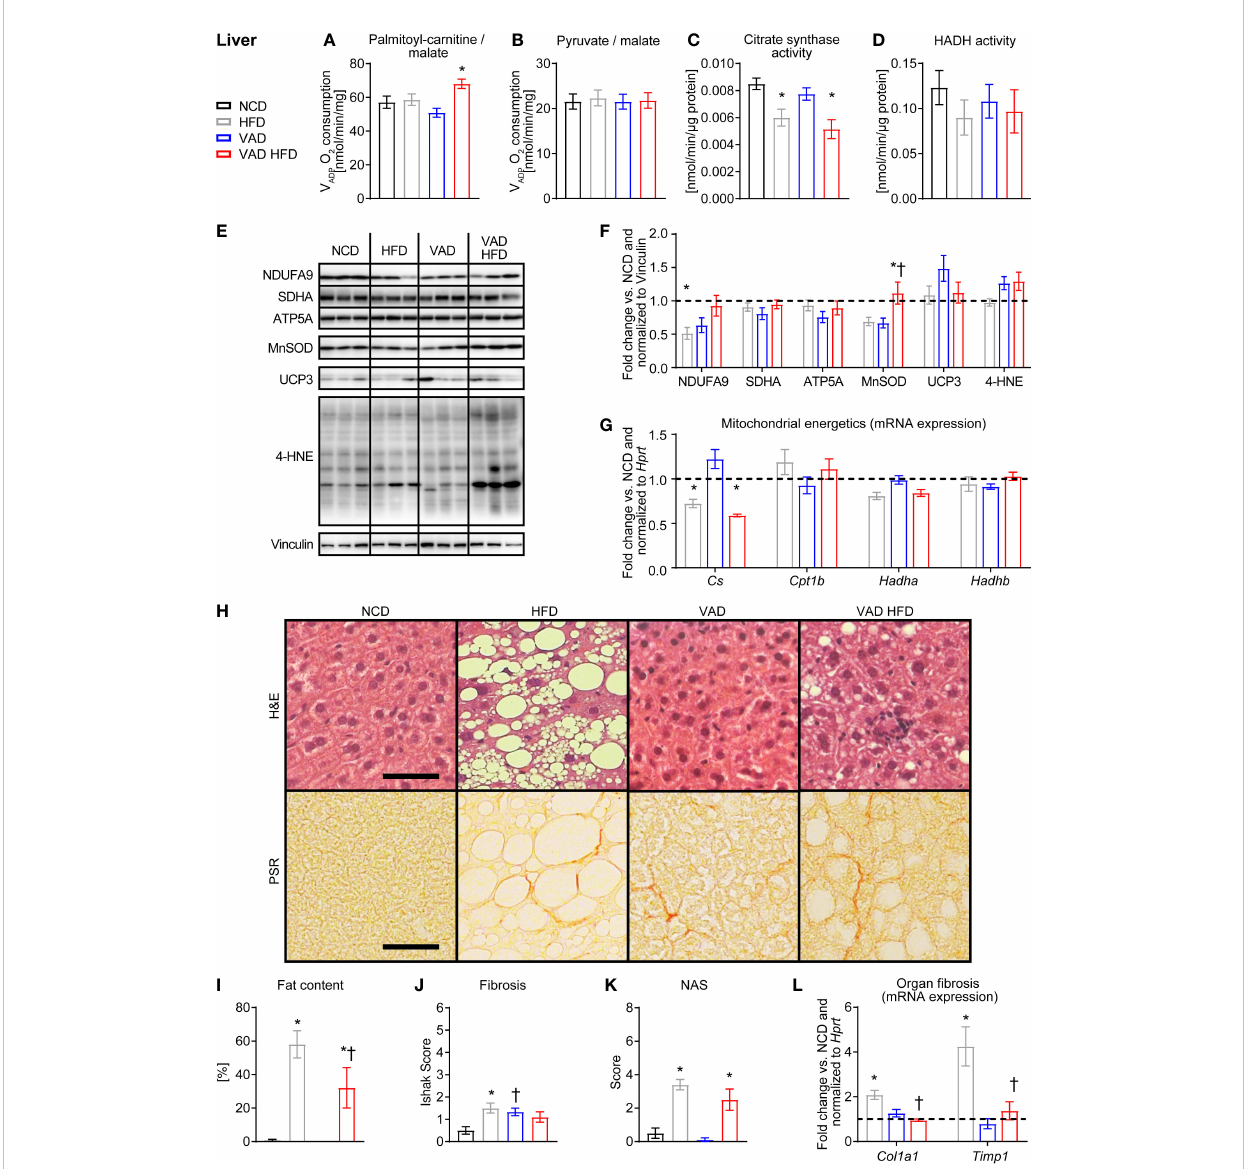
FIGURE 2 VitA modulates steatosis and fi brosis in liver tissue in DIO independent of mitochondrial function. Data are reported as mean values ± SE. Two-way ANOVA was performed to analyze differences by HFD feeding and VitA. Results of post-hoc analyses for each comparison are summarized by symbols as de fi ned: # p<0.05 for HFD feeding, $ p<0.05 for VitA, and & p<0.05 for the interaction between HFD feeding and VitA. V ADP of isolated liver mitochondria with (A) palmitoyl-carnitine (#, &) and (B) pyruvate each combined with malate as substrates (n=7-8). (C) Citrate synthase (#) and (D) HADH activity in liver tissue (n=6-8). (E) Representative immunoblots and (F) densitometric analysis of NDUFA9 (&), SDHA, ATP5A, MnSOD (&), UCP3, and 4-HNE ($) normalized to Vinculin. Data are presented as fold change relative to NCD (assigned as 1.0; dashed line), n=6. (G) mRNA expression of transcripts involved in mitochondrial energetics ( Cs: #, &; Hadha: #). Data are presented as fold change relative to NCD and normalized to Hprt (assigned as 1.0; dashed line), n=7-8. (H) Representative H&E and PSR stains of liver sections (scale bars: 50 m m each). Quanti fi cation of (I) fat content (#), (J) fi brosis (&), and (K) NAFLD activity scores (NAS, #), n=9-10. (L) mRNA expression of transcripts involved in organ fi brosis ( Col1a1: #, $, &; Timp1: #, $, &). Data are presented as fold change relative to NCD and normalized to Hprt (assigned as 1.0; dashed line), n=7-8. *p < 0.05 vs. normocaloric diet same VitA availability, † p<0.05 vs. VitA suf fi ciency same caloric